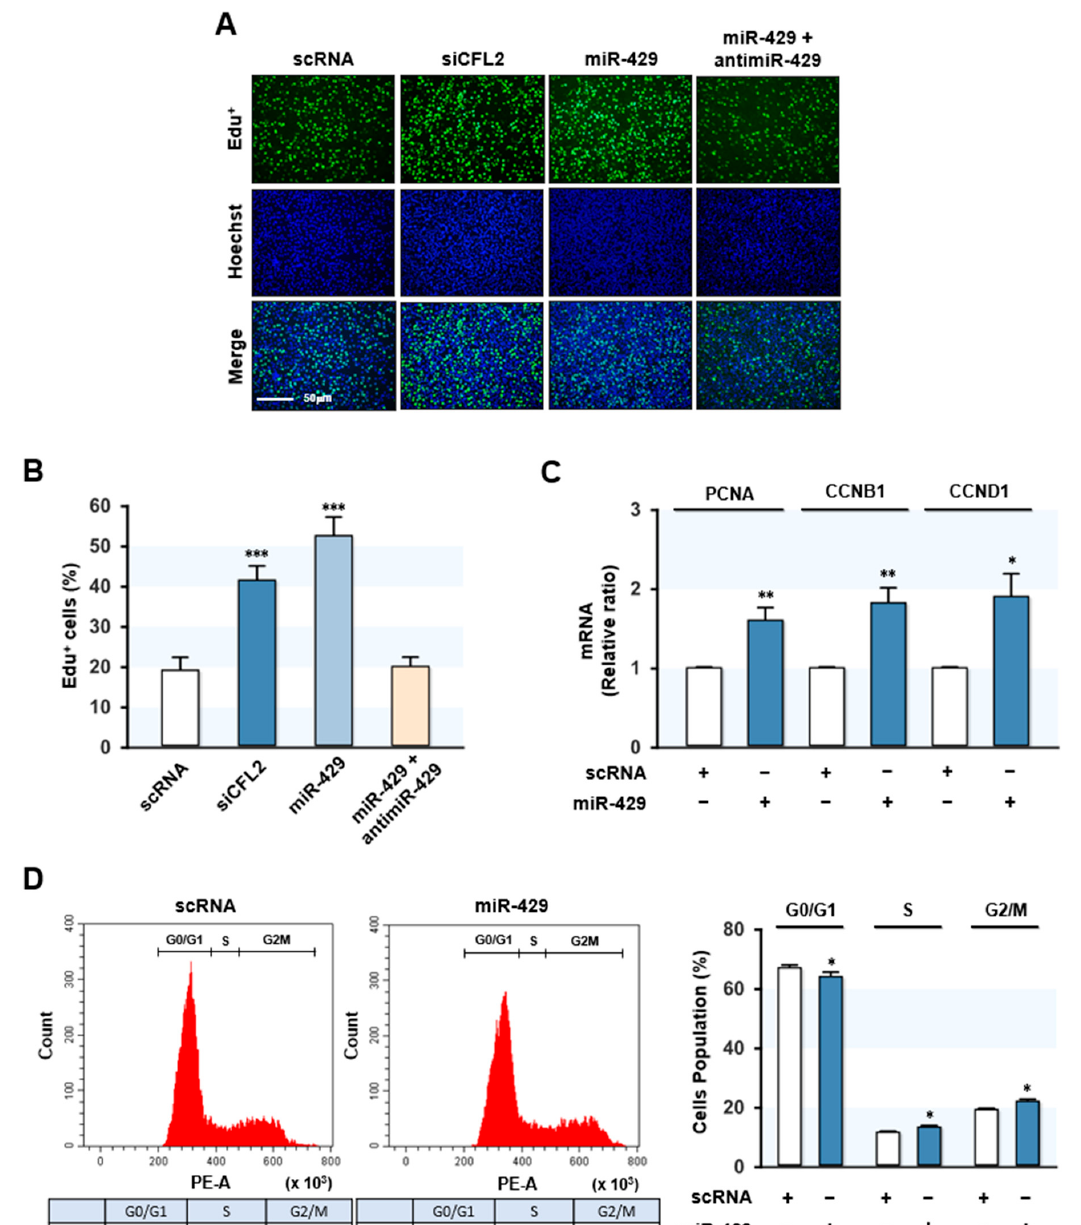
Figure 4. MiR-429-3p mimic promoted myoblast proliferation and cell cycle progression. C2C12 myoblasts were trans- fected with scRNA control, siCFL2, miR-429-3p mimic, or antimiR-429 (200 nM). ( A ) EdU assays were performed after 24 h of transfection. Cells were labeled with 10 μ M of EdU (green), and nuclei were stained with Hoechst (blue). Scale bar: 50